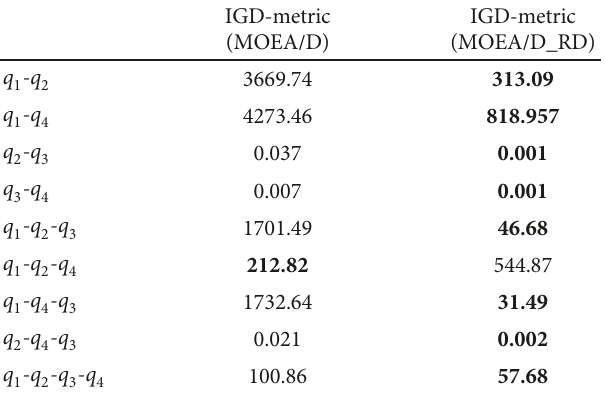
Table 2: Comparison of IGD-metric of MOEA/D_RD and MOEA/D.